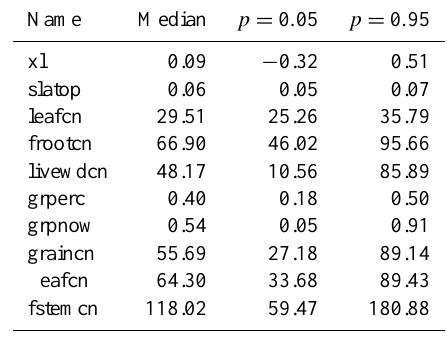
Table 2. Posterior information on the parameters.